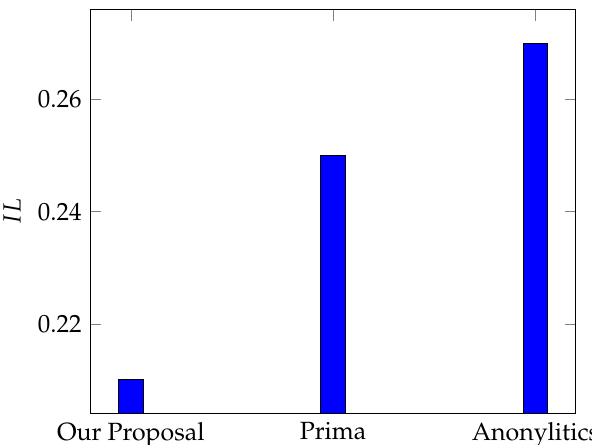
Figure 16. Information loss comparison between the existing